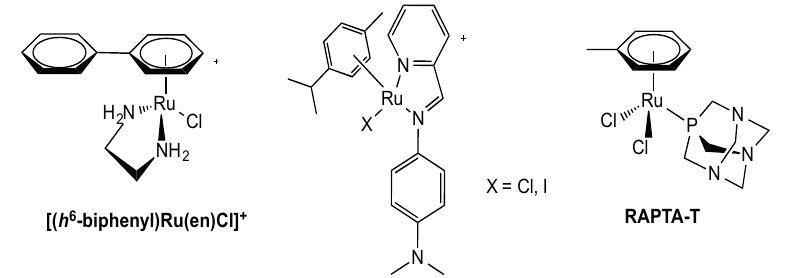
Figure 3. Organometallic Ru(II) arene